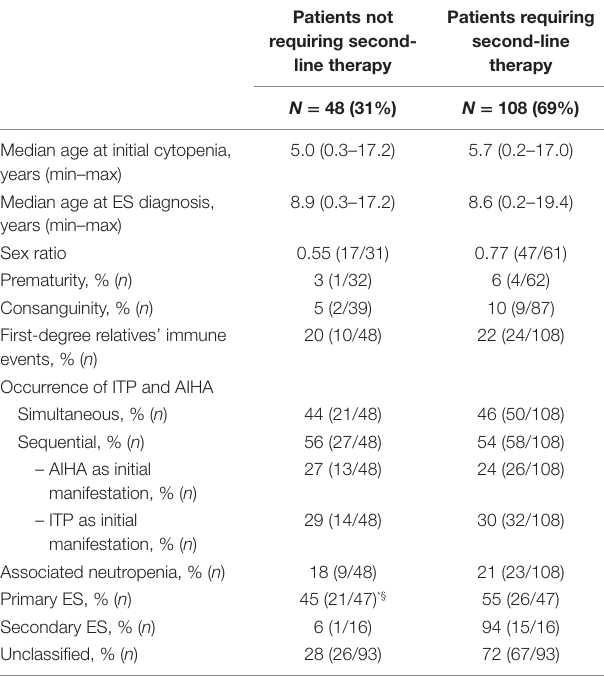
Patients not requiring second-